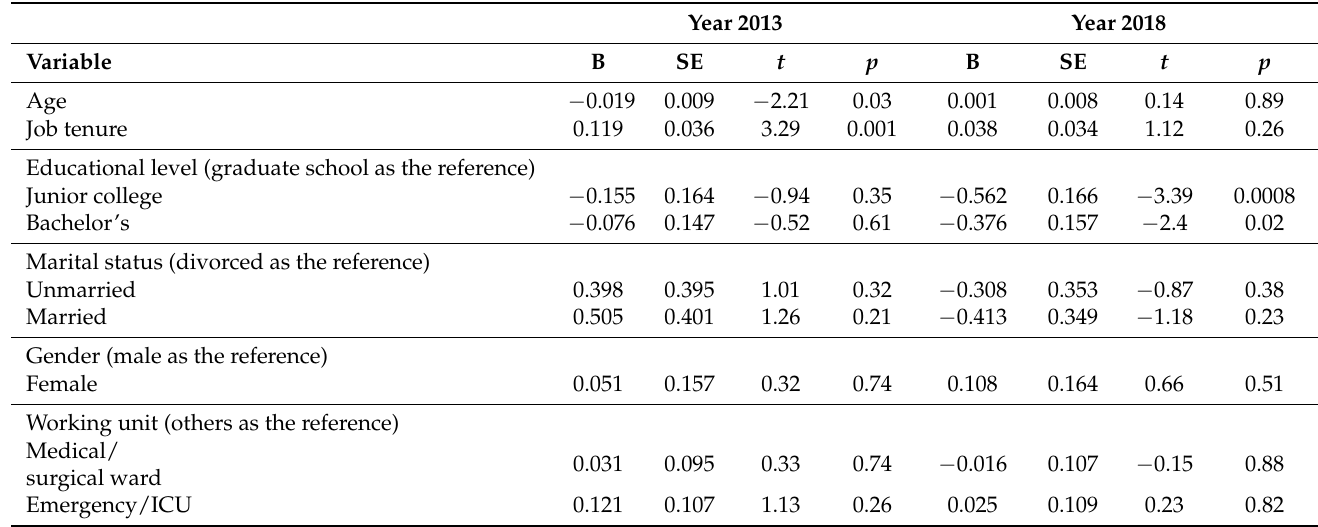
Table 3. Predictive variables of perceived barriers to palliative care in 2013 and